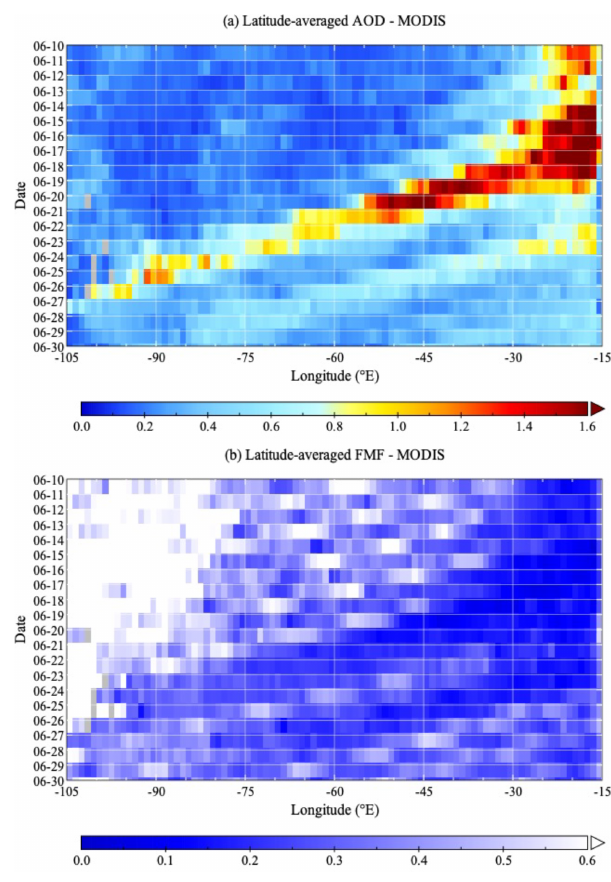
Figure 3. Tracks of trans-Atlantic dust plumes over 10–30 June 2020 as revealed in the longitude–time Hovmöller diagrams of MODIS daily AOD (a) and FMF (b) . AOD and FMF are averaged over 5–30 ◦